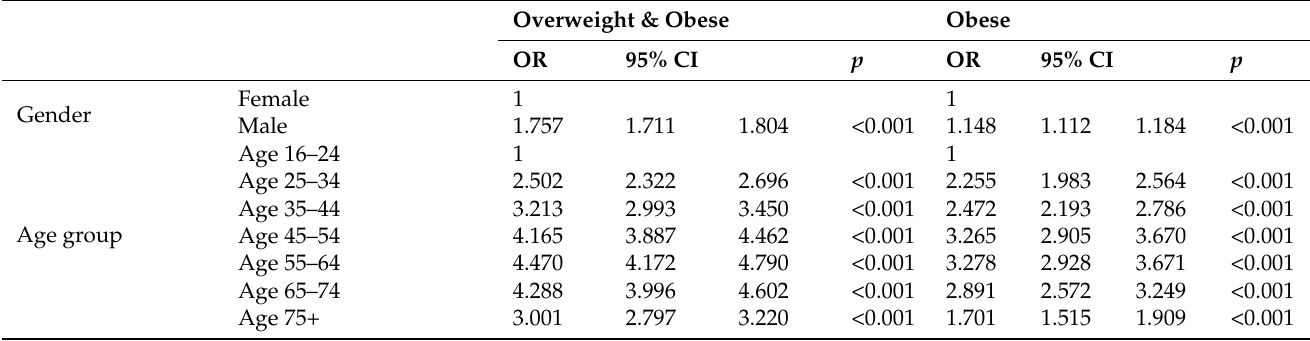
Table 2. Full results of multivariate logistic regression model predicting odds of overweight and obesity by